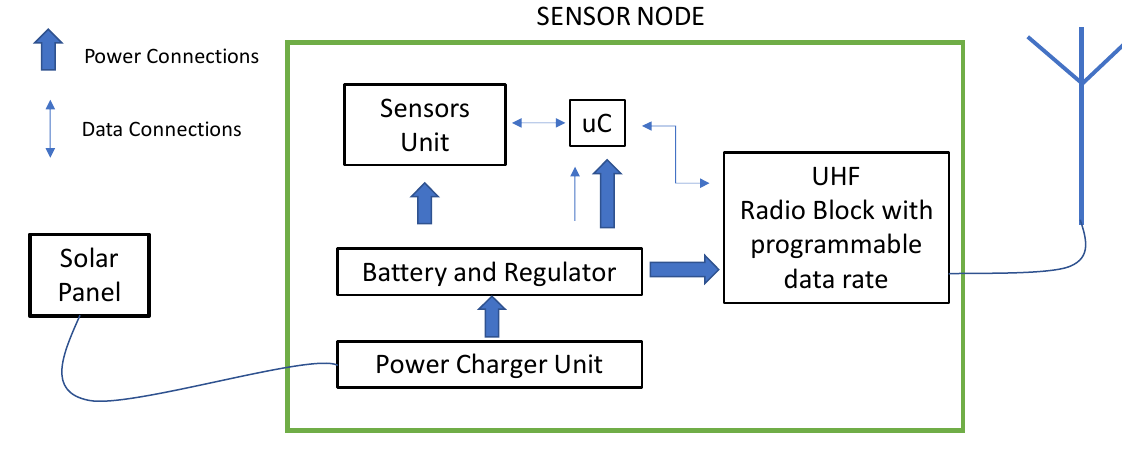
Figure 1. Architecture of the sensor node.